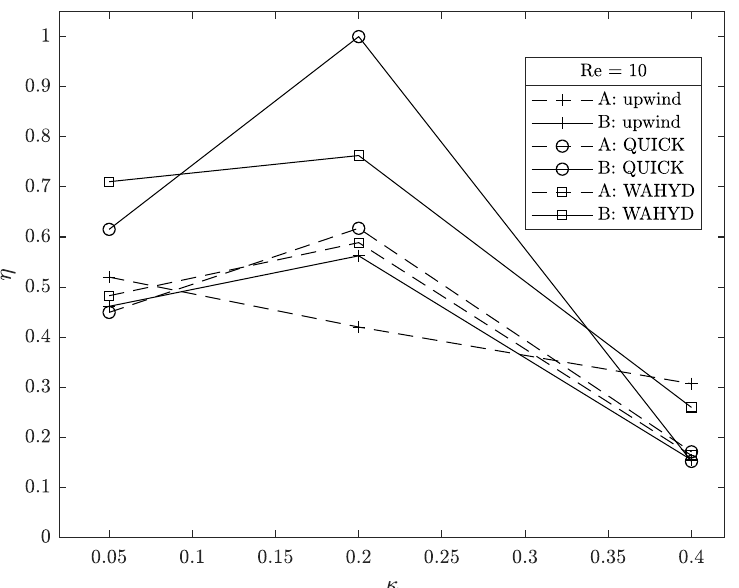
Figure 33. Computational efficiency as function of κ for the flow around a cylinder case with Re = 10 using the E